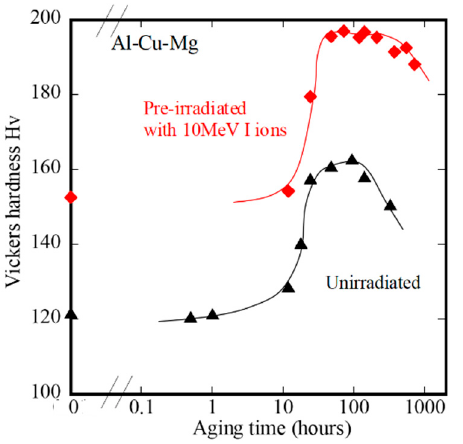
Figure 12. Vickers hardness as a function of aging time for Al-Cu-Mg specimen pre-irradiated with 10 MeV ions to the fluence of 5 × 10 15 / cm 2 . Data for unirradiated specimen are also plotted. Aging temperature is 423 K.